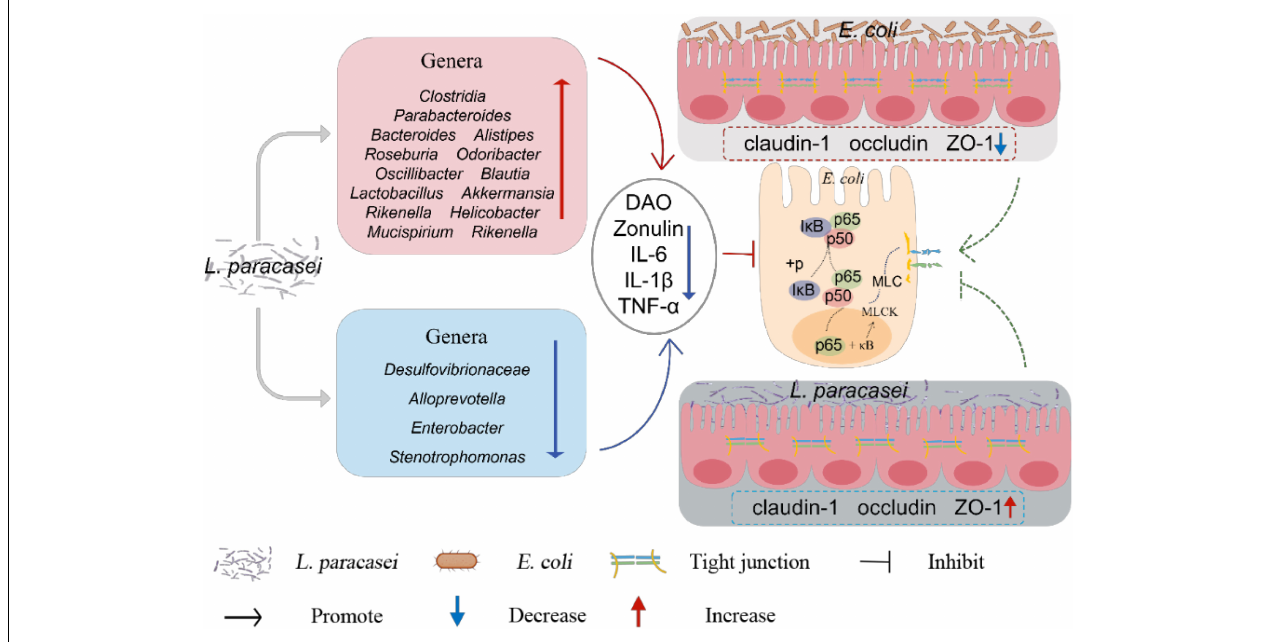
FIGURE 13 | Overall mechanisms of L. paracasei for the treatment of